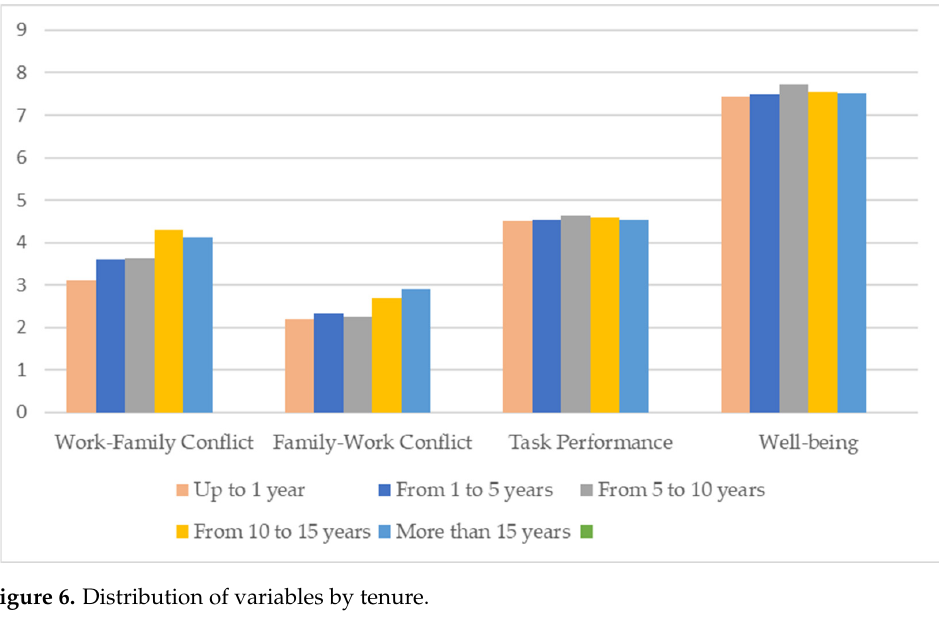
Figure 6. Distribution of variables by tenure.